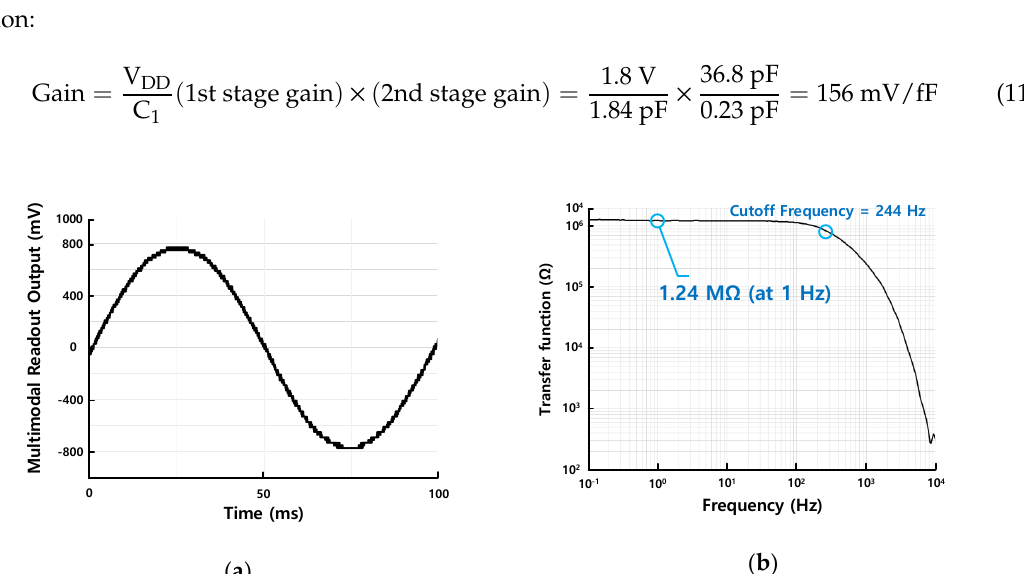
voltage to the input capacitance. The gain of the capacitive-sensing mode is expressed by the following equation: Figure 11. ( a ) Linearity expressed as the ratio of the digital output code to the input resistance. ( b ) Resistance noise floor.